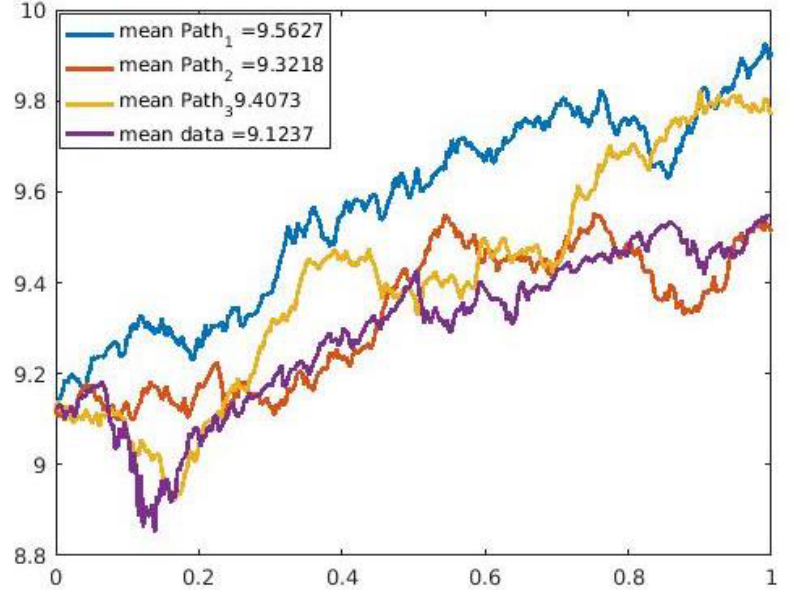
Figure 12. Graph showing three sample paths and time series plot for the NASDAQ index. For this time series, we see that sample path 2 closely predicts it and by comparison of the means, sample path 2 is closer in value to the mean of the time series